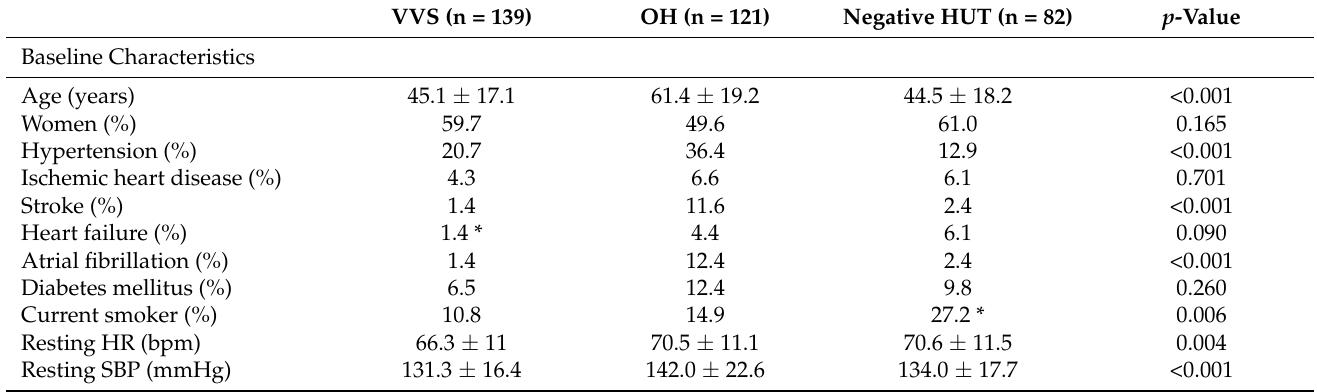
Table 1. Baseline characteristics and hemodynamic parameters in VVS, OH and negative head-up tilt